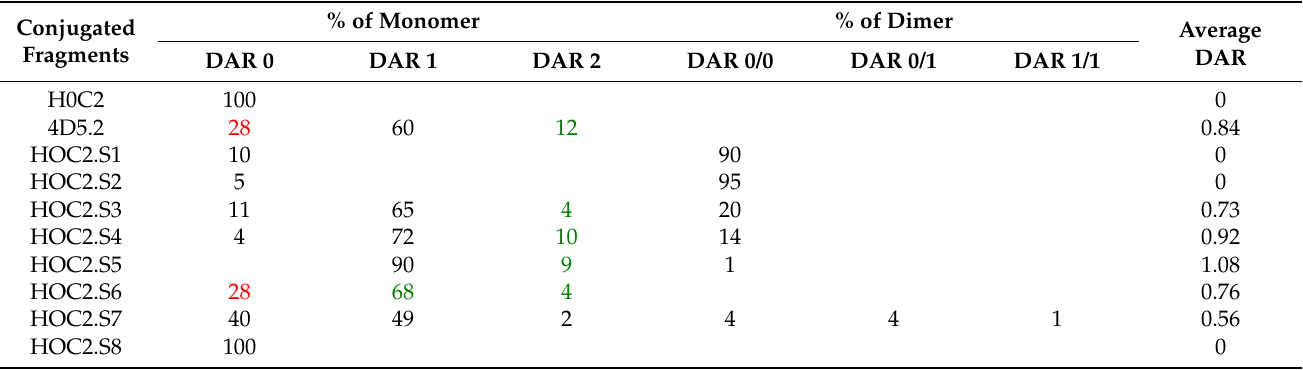
Table 1. Analysis of the conjugated fragments 4D5.2-MMAF and H0C2.Sx-MMAF (x = 0 to 8) by MS according to their oligomerization state and calculated average DAR. Black species: expected mass increment (+923 Da for DAR 1 or +1846 Da for DAR 2). Green species: resulted from the stabilization of maleimide(s) into maleic amide(s) by hydrolysis (+18 Da mass increment from a DAR 1 or +36 Da mass increment from a DAR 2). Red species: resulted from the deconjugation (loss) of an aminocaproic-MMAF on a DAR 1 and transformation of maleimide into maleic anhydride ( − 809 Da loss of mass from DAR 1, also corresponding to a +114 Da mass increment from a native DAR